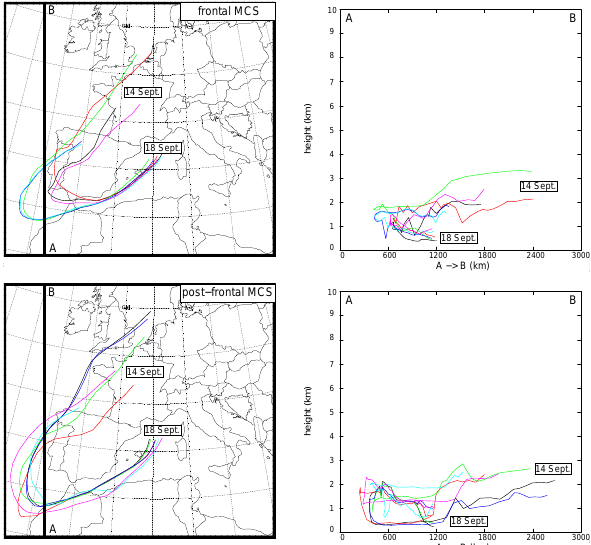
Fig. 18. Backward trajectories of some air parcels taken in the moist Fig.18. Backwardtrajectoriesofsomeairparcelstakeninthemoistlow-levelflowfeedingthe18Sept. 2009precipitatingsystemobtained